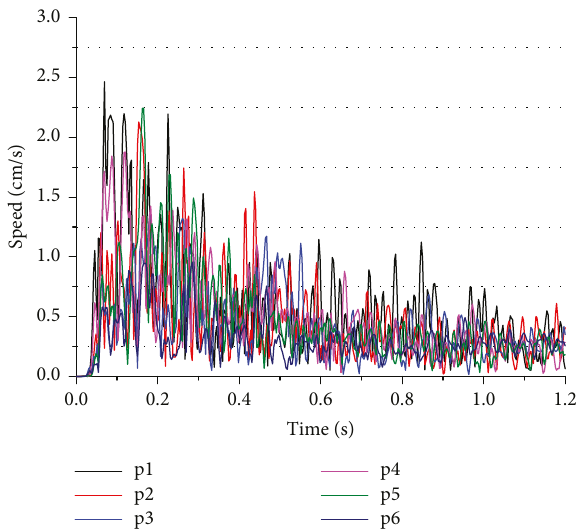
Figure 32: Time-history response curve of velocity at characteristic points on the embankment in the third excavation.